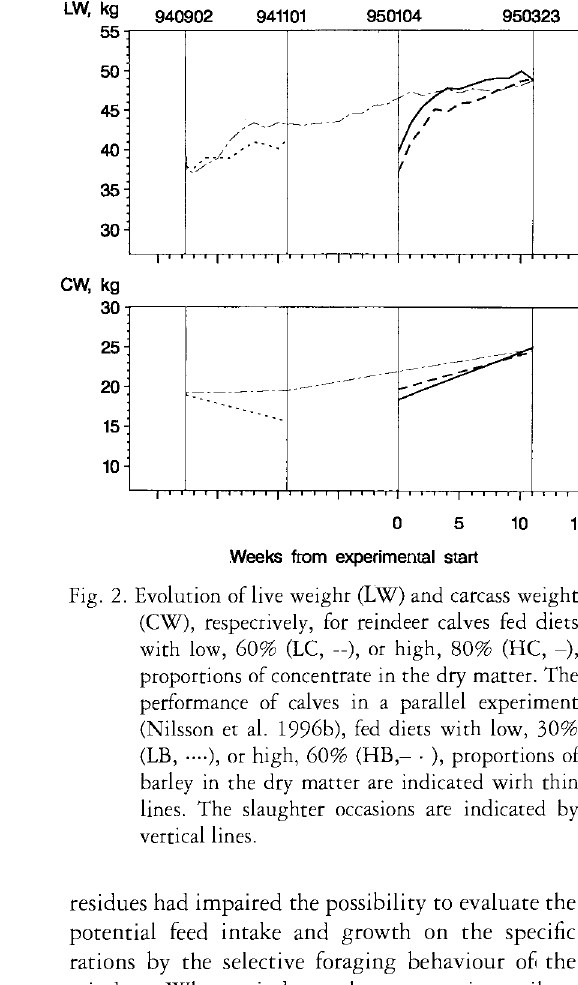
Fig. 2. Evolution of live weighr (LW) and carcass weight (CW), respecrively, for reindeer calves fed diets with low, 60% (LC, -), or high, 80% (HC, -), proportions of concentrate in the dry matter. The performance of calves in a parallel experiment (Nilsson et al. 1996b), fed diets with low, 30% (LB, ••••), or high, 60% (HB,- • ), proportions of barley in the dry matter are indicated wirh thin lines. The slaughter occasions are indicated by vertical